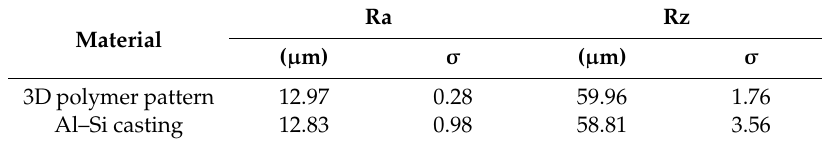
Figure 4. Surface linear roughness profiles for: ( a ) polylactide (PLA) pattern made by fused deposition modeling (FDM), ( b ) aluminum casting reproduced from polymer pattern. Table 2. Surface roughness parameters Ra and Rz with calculated standard deviation σ .